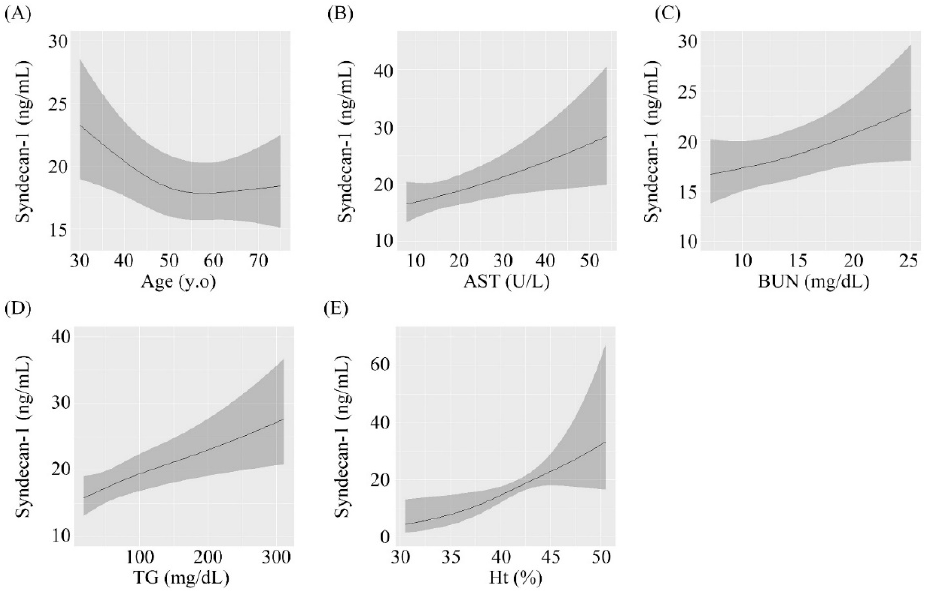
Figure 1. Associations between serum syndecan-1 and different parameters. (A) Age, (B) Aspartate aminotransferase, (C) Blood urea nitrogen, (D) Triglyceride, (E) Hematocrit. According to nonlinear regression analysis, serum syndecan-1 concentrations were significantly related to age, AST concentration, BUN concentration, triglyceride concentration, and Ht. These relationships were independent associations. Significant nonlinear associations were not observed for each variable.